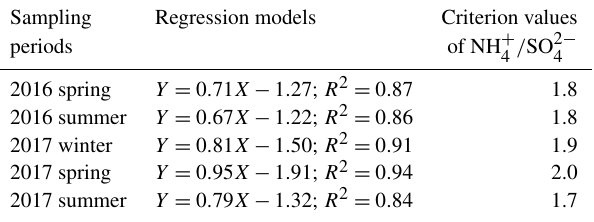
Figure 5. Scatter plots of molar ratios of NO − / SO 2 − NH + in Nanjing during the different seasons. 4 4 Table 1. The regression models between NO − / SO 2 − NH + ( X ) along with the criterion values of NH + 4 4 ammonium-rich regime during the sampling periods.